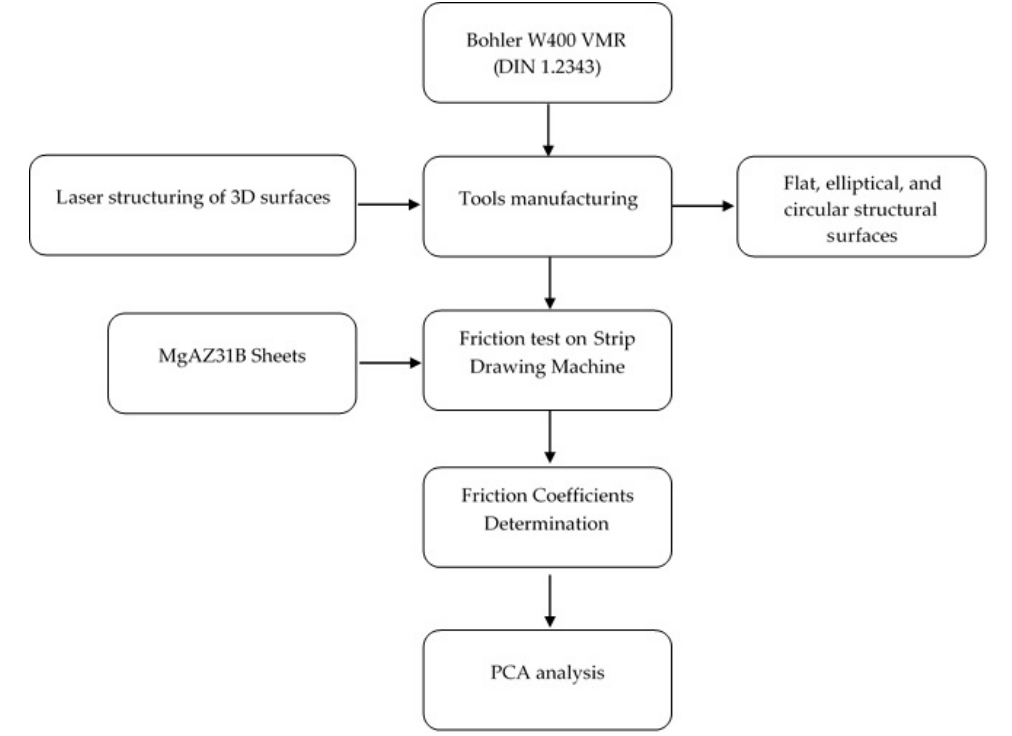
Figure 1. Summarize the experimental and theoretical strategies employed in this work.